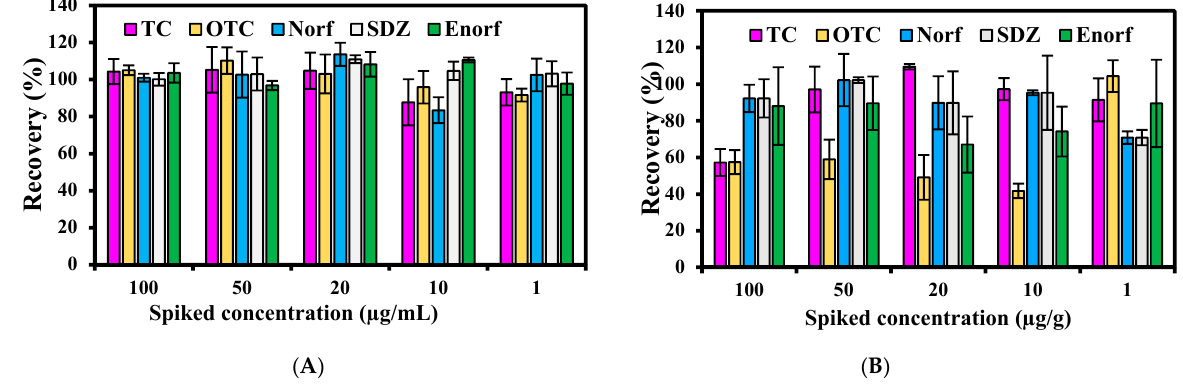
Figure 1. VAs recovery in liquid fraction ( A ) and solid fraction ( B ) at pH 1.5, mobile phase (1).